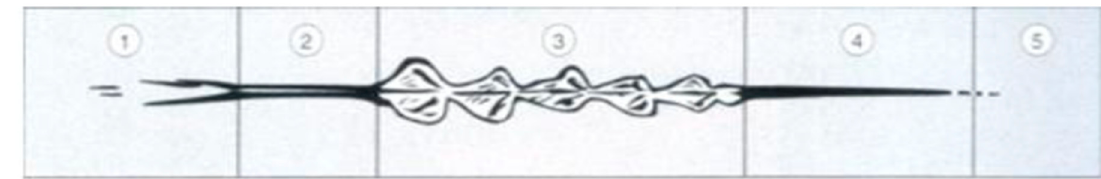
Figure 19. The different stages of dry time as determined visually versus time. Stage 5 is considered dry. Alkyd Paint and Catalyst